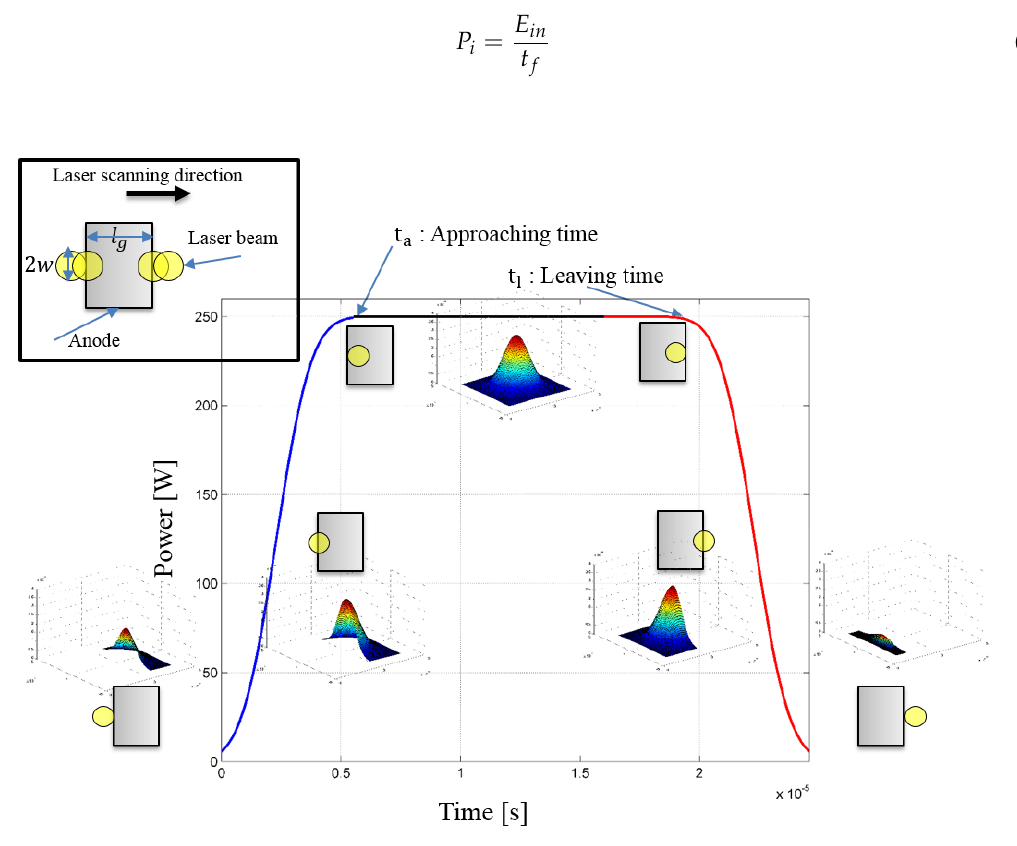
Figure 3. Description of laser power irradiation with a laser power of 250 W, speed of 5000 mm/s, and distance of 100 μm .